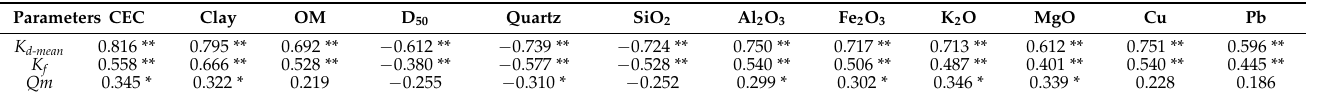
Table 3. Correlation between adsorption parameters and physicochemical properties of